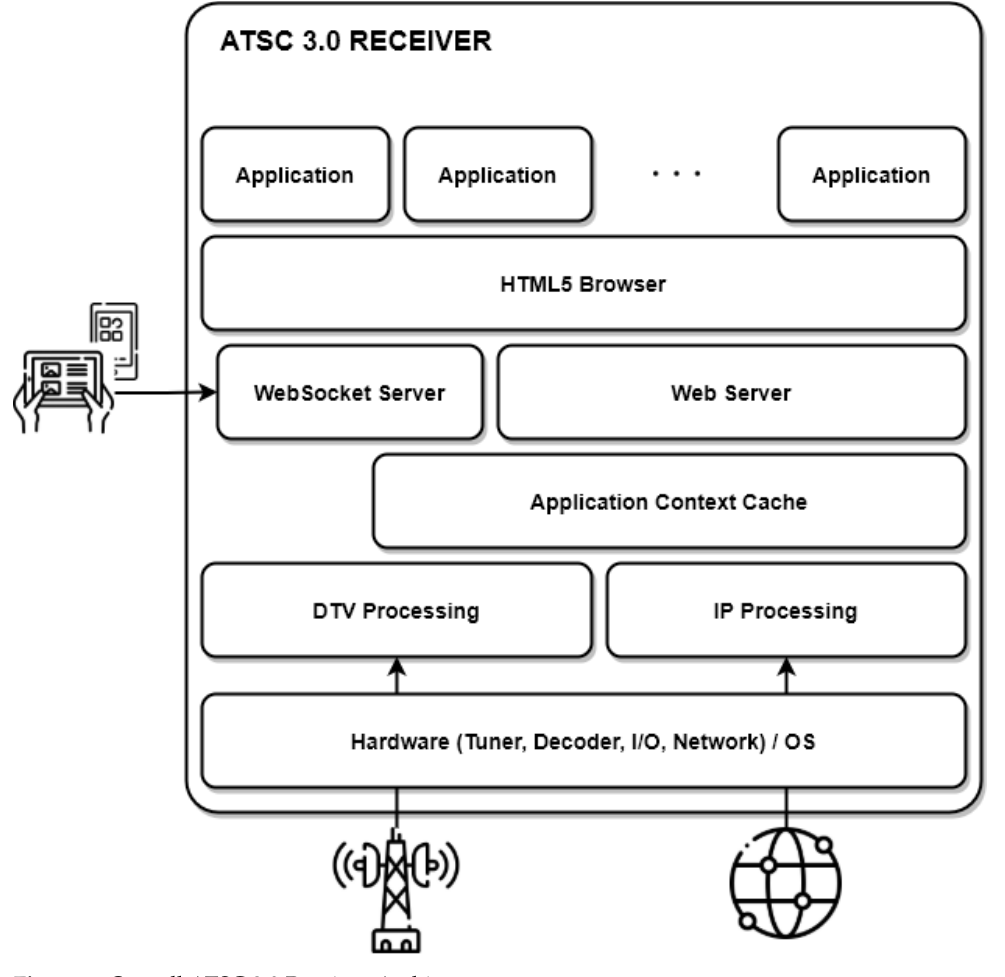
Figure 5. Overall ATSC 3.0 Receiver